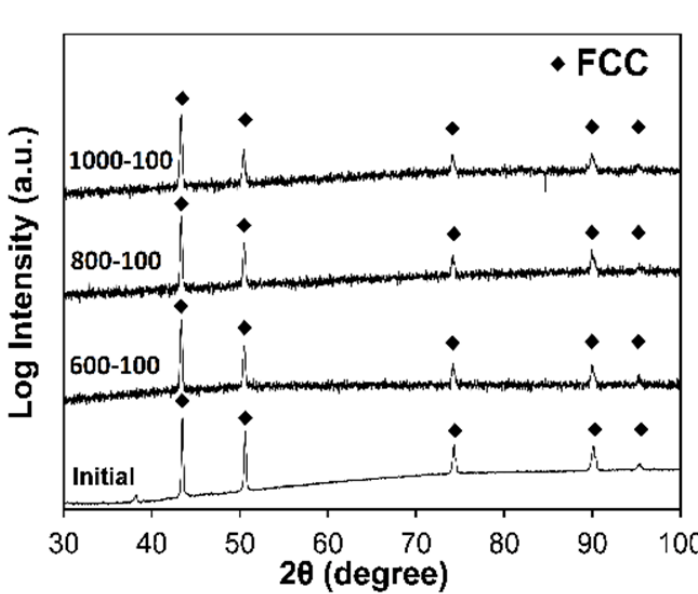
Figure 5. XRD patterns of the stir zone after various parameters of FSW. Indeed, TEM examination (Figure 6) shows a decrease in the fraction of the M 23 C 6 carbides (shown by arrows in Figure 6) after welding to ~1–2%, in comparison with ~4% in the initial condition. A more pronounced reduction in the volume fraction of the carbides is most likely caused by an increased tool rotation rate or decreased tool traverse speed (due to which the SZ temperature raised and caused the dissolution of the carbides). The average size of the carbides was found to be 370 nm without obvious bimodal